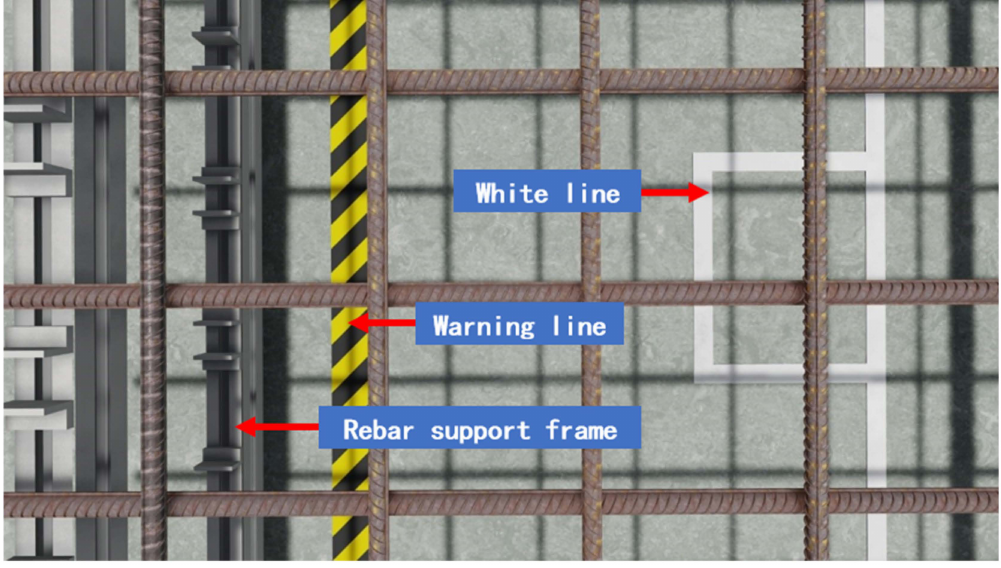
Figure 4. Virtual scene